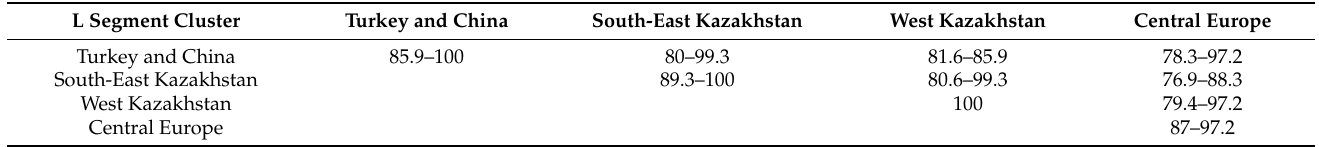
Table 4. Nucleotide sequence identity of the partial Tula virus (TULV) L segment sequences in Kazakhstan and other Eurasian regions